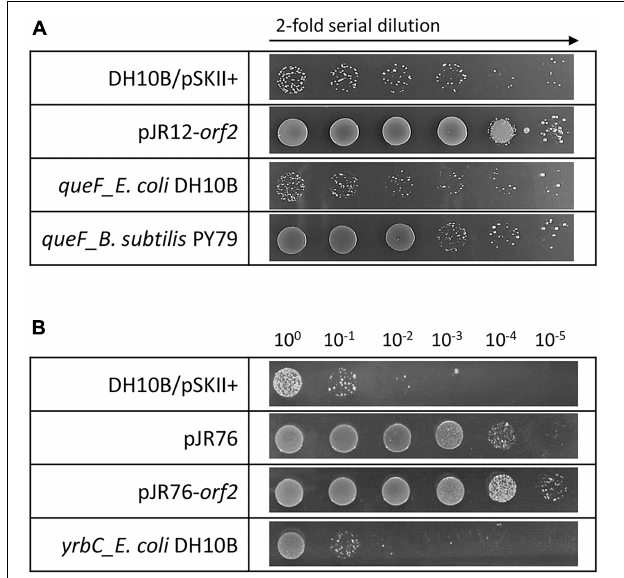
FIGURE 3 | Drop assays in the presence of perchlorate of clones overexpressing: (A) pJR12- orf2 , E. coli DH10B queF and B. subtilis PY79 queF , and (B) pJR76, pJR76- orf2 and E. coli DH10B yrbC . Cultures were grown overnight at 37 ◦ C, drops of 2-fold (A) or 10-fold (B) serial dilutions were plated on LB-Ap containing 125 mM of sodium perchlorate and plates were incubated for 48 h at 37 ◦ C. E. coli DH10B bearing empty pSKII+ (pBlueScript II SK +) vector was used as a negative control.